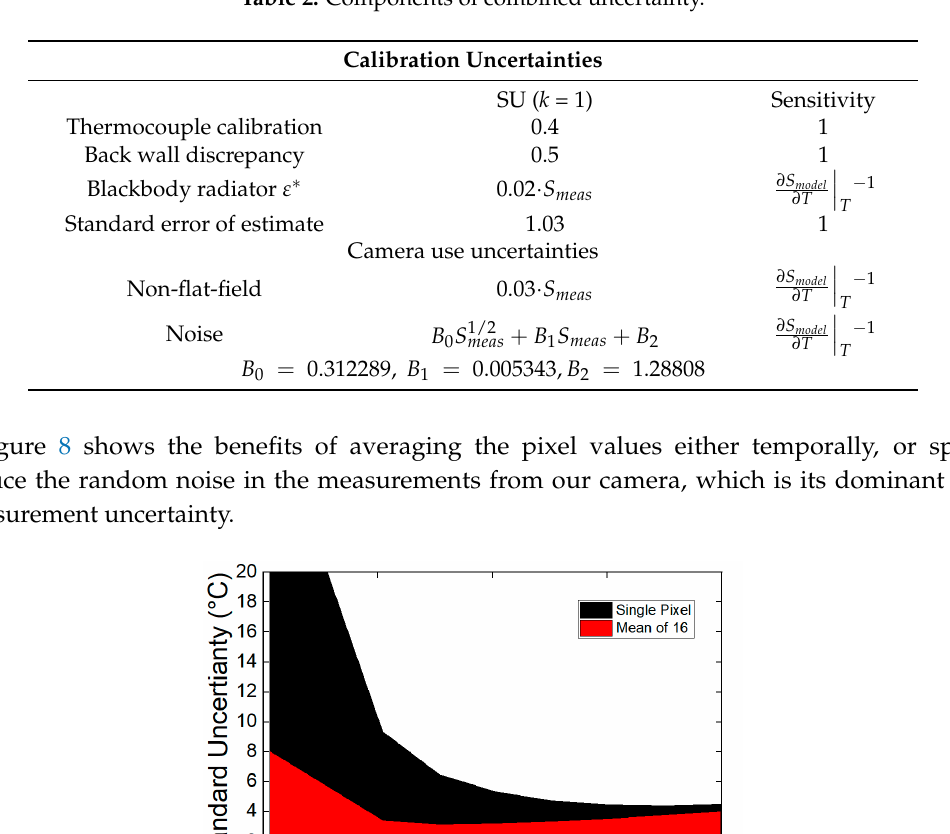
Figure 7. The Noise Equivalent Temperature Difference for the Thermal PiCam system. Each value is taken as the mean across the entire image. The NETD can be reduced by √ N with pixel averaging where N is the number of pixels in the mean average. Table 2. Components of combined uncertainty.